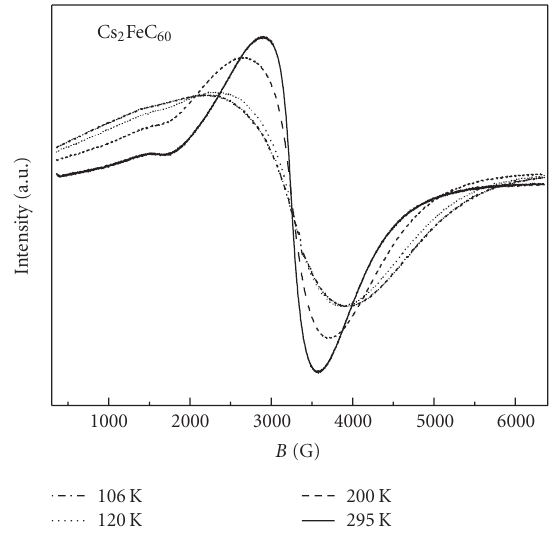
Figure 7: EPR spectra at di ff erent temperatures of Cs 2 FeC 60 .